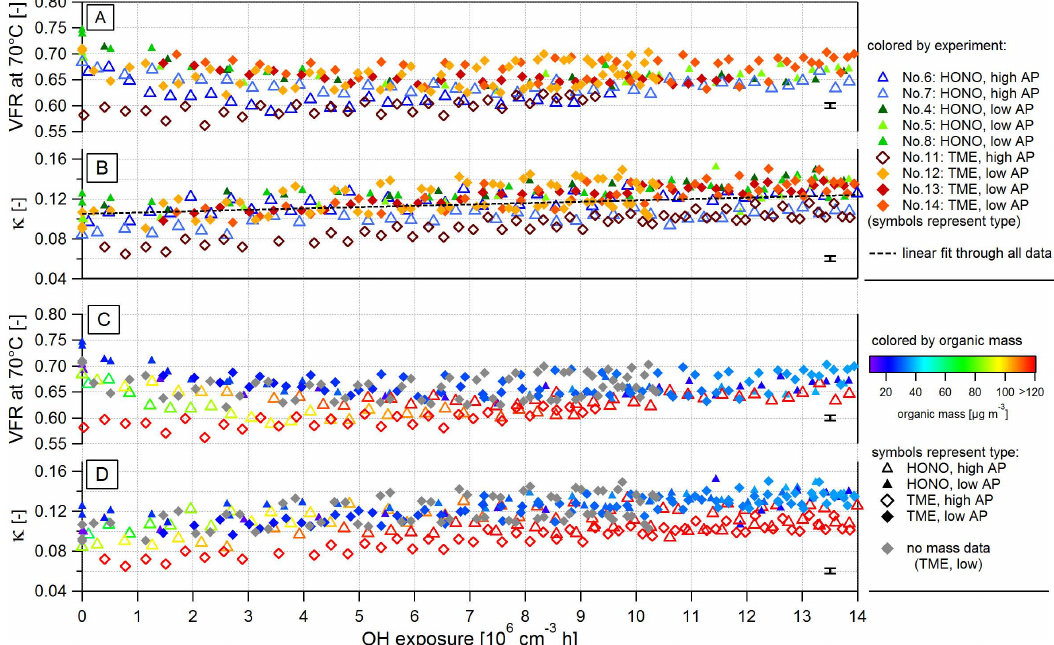
Fig. 7. Volatility, expressed as VFR at 70 ◦ C, and hygroscopicity parameter κ plotted against the “chemical clock” OH exposure shown for the reaction with OH part of the experiments only. The color code in panel (a) and (b) represents the individual experiments; while the symbols shape and filling indicate the experiment type and α -pinene (AP) input concentration, respectively. The filled symbols represent the low AP (10ppb) and open symbols the high AP (40ppb) precursor concentration experiments. Panel (c) and (d) show exactly the same data as panels (a) and (b) , now arranged in groups of experiment type and color coded by their wall-loss corrected organic aerosol mass (note that the red color ranges from 120 to max. 255µgm − 3 ). Exemplary error bars at the right end of each panel represent the precision of the